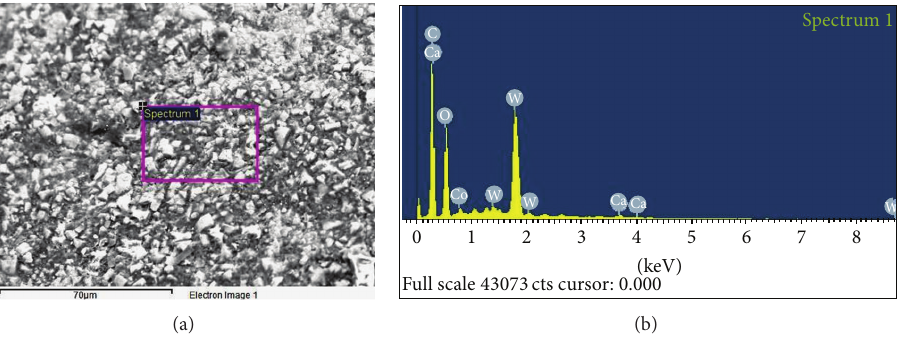
Figure 6: (a) Coal/rock intermixed zone (dark coloured); (b) EDS spectra of selected area showing the presence of coal and rock material.